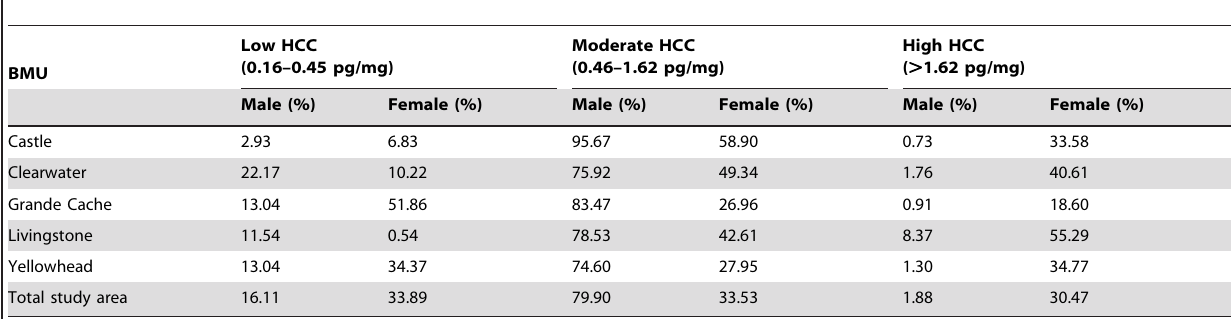
Table 4. Percent area of the bear management units (BMU) and study area classified as low, moderate, and high HCC based on the geographic distribution of predicted male and female HCC